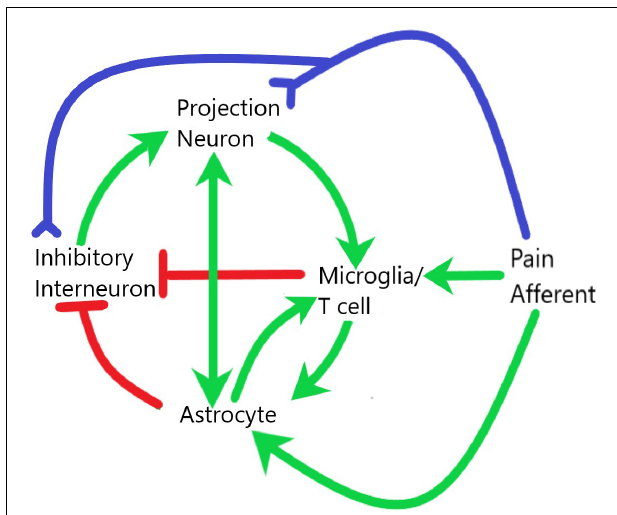
FIGURE 2 | Interaction of glial and neuronal cells within the spinal cord during central sensitization and neuroinflammation. Pain afferents are subject to neuropathic or inflammatory insult and signals of real or potential tissue damage are sent to both the projection neurons and inhibitory interneurons within the dorsal horn of the spinal cord. The release of neuropeptides in the synaptic cleft as well as the increased electrical activity at these synapses leads to activation of both microglia and astrocytes. These glial cells then interact with each other and with neurons to establish a systemic positive feedback system that is self-sustaining. Green lines demarcate activation, red lines demarcate inhibition, blue lines demarcate axonal